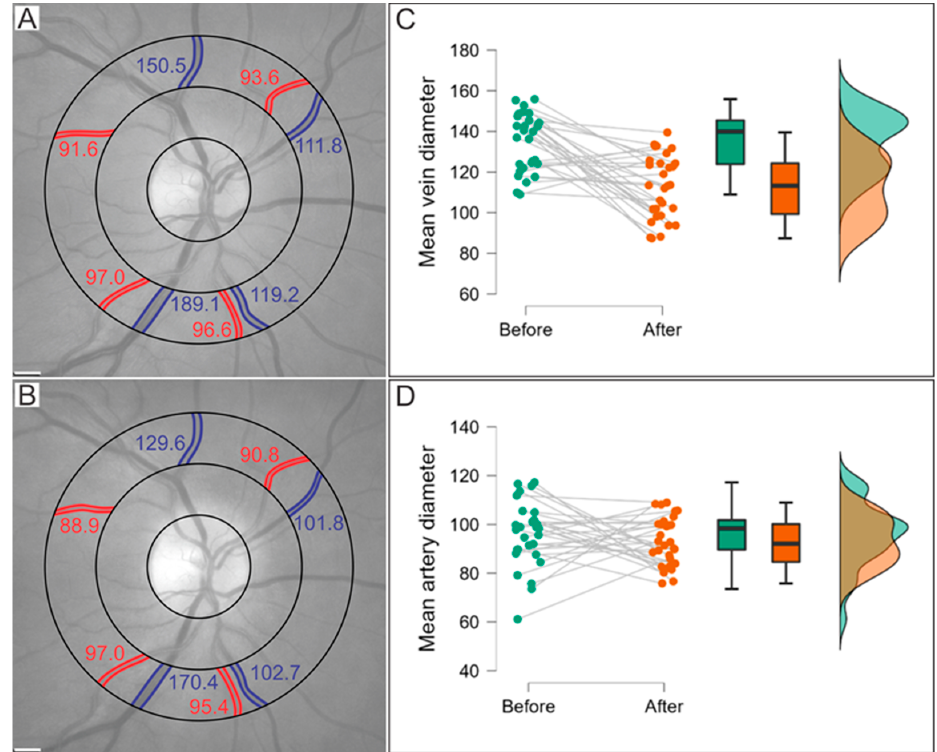
Figure 1. Comparison of the vessel diameters in the acute phase and at 1-year follow-up. Automatic retinal image analyzer software was used to analyze the mean the mean diameters (in μ m) of the four main veins (blue) and four main arteries (red). There was a notable decrease in the vessel diameter from the acute phase ( A ) to 1-year follow-up ( B ). Raincloud plot of mean vein diameters ( C ); the mean difference (95% CI): 22.9 (17.0–28.9) and mean artery diameters ( D ); the mean difference (95% CI): 3.2 ( − 1.6–8.0).